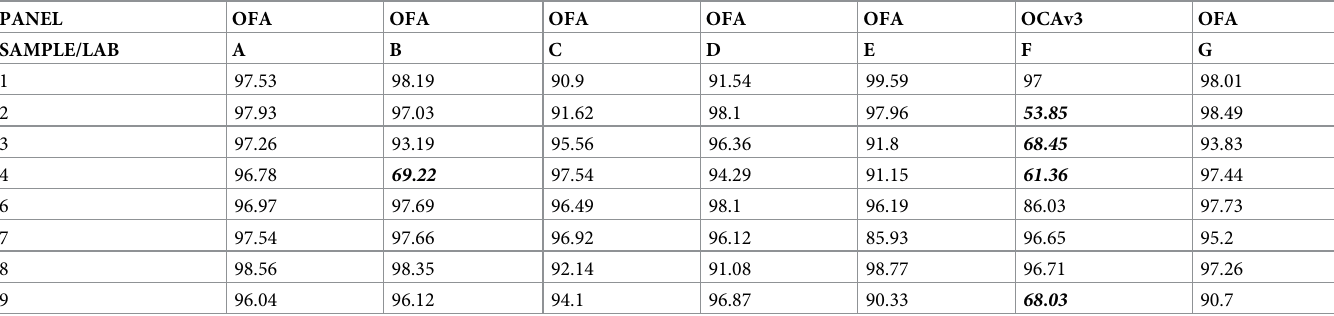
Table 9. Phase 2 DNA uniformity values. PANEL